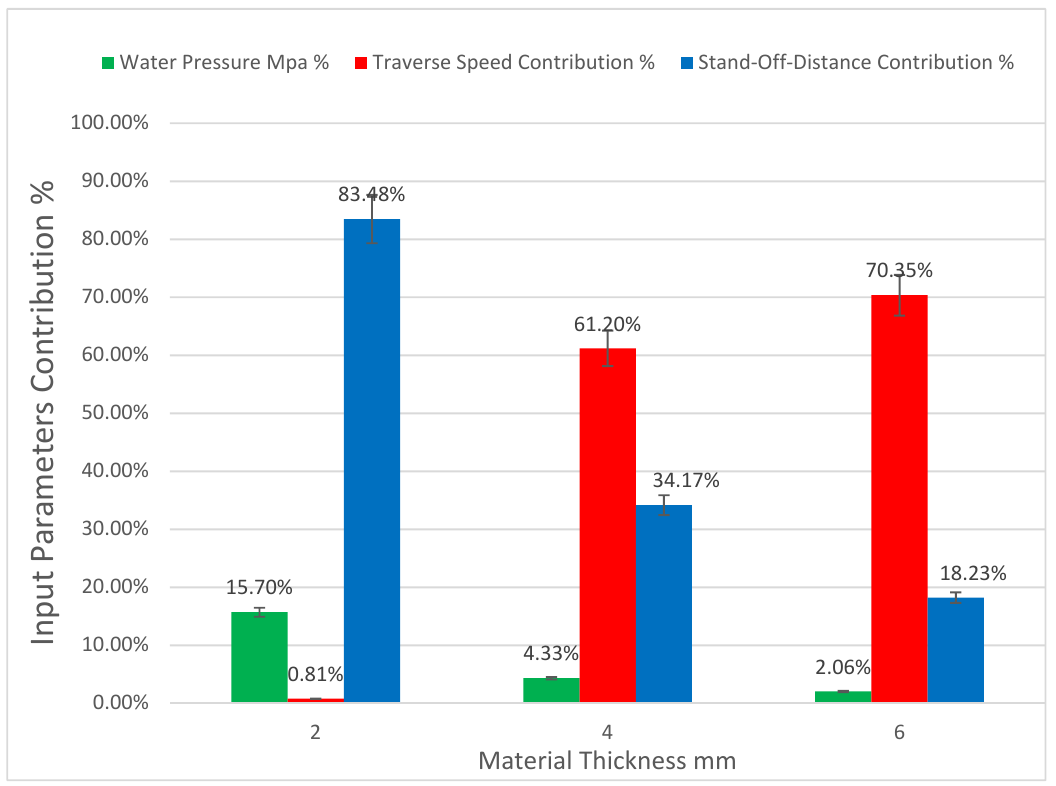
Figure 11. Input parameter contributions to kerf taper angle of the various material thicknesses of SPF-UPE composite cut with waterjet cutting technology.